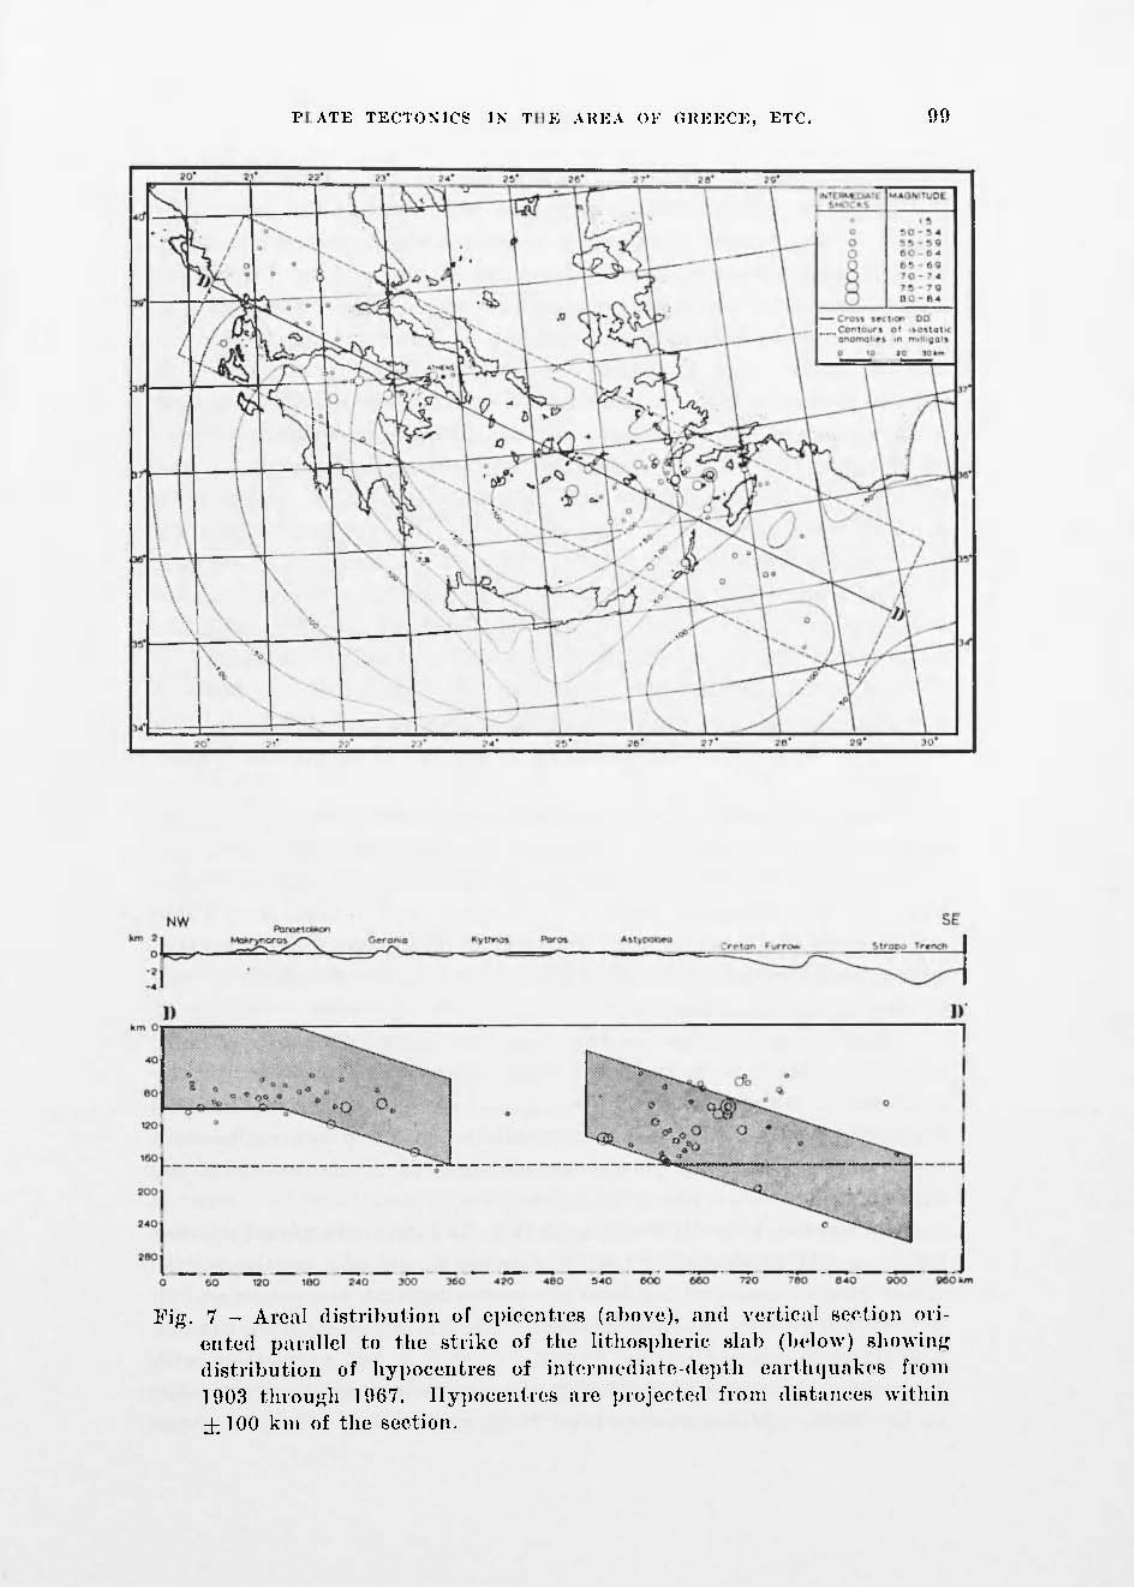
ente!! pamIIcI to the strikc of the lithospherie :i1ah (1H'low) showing distribution of hypoccnlrcs of intprnledinte·(lepth earth<Junkps from 1\103 thl'Ough 1\167. lIypocentres arc projcptc,l fl'O!ll ,1istalleeH within ± 100 km of the